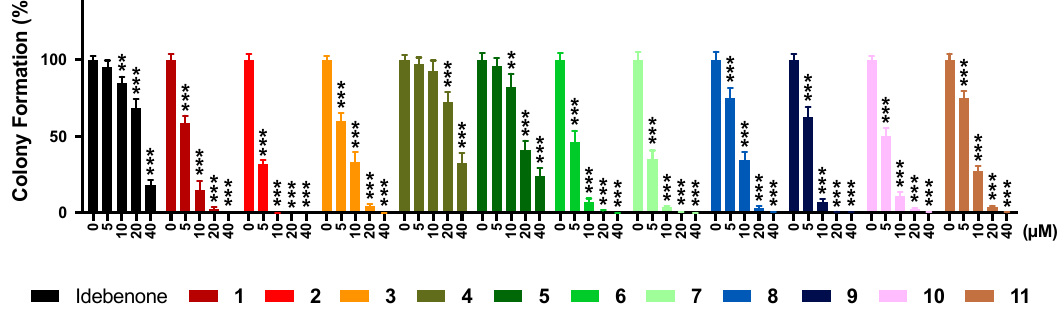
Figure 4. Effect of test compounds on colony formation. Cells were exposed to reference or test compounds (0–100 μ M) for 14 days before colonies (>50 cells) were quantified. Data was expressed as mean ± SEM of 3 independent experiments with 4 parallel wells per experiment. Two-way ANOVA was performed to compare test concentrations against the non-treated control: *** p < 0.001, ** p < 0.002, * p < 0.033. Full datasets available in Table S8.